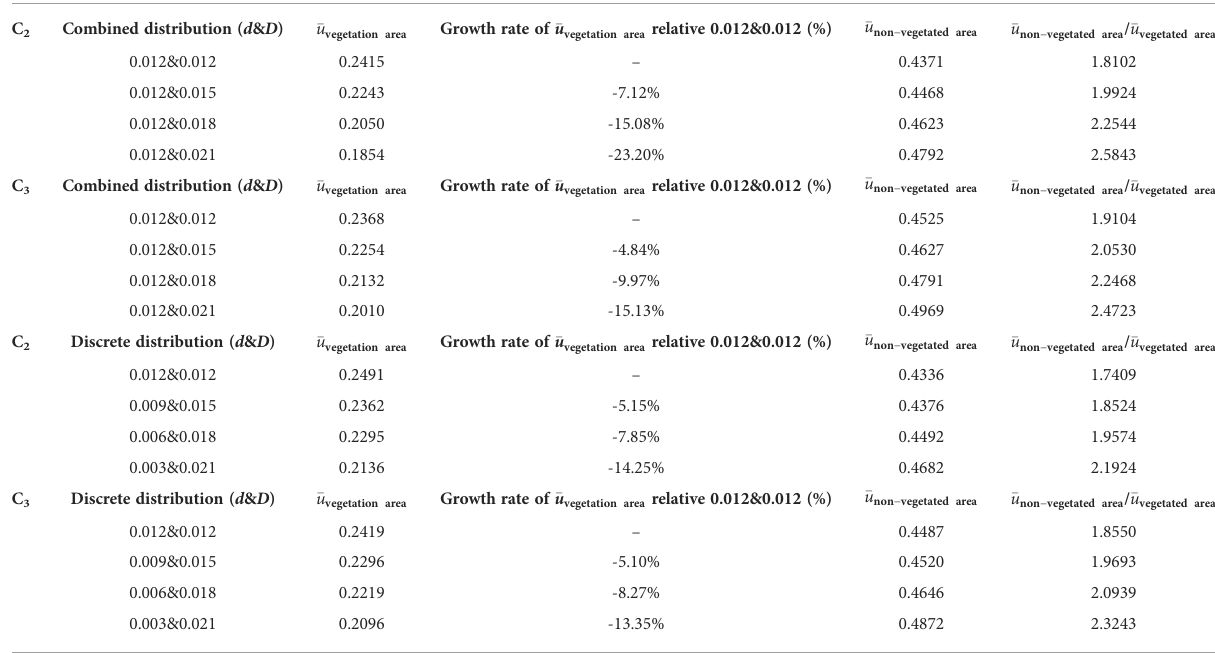
TABLE 1 The average streamwise velocity (cid:1) u value and its rate of change between C 1 and C 2 cross-sections under different distribution patterns when the non-submerged condition h is 0.06 m. Vegetation non-submerged state ( h